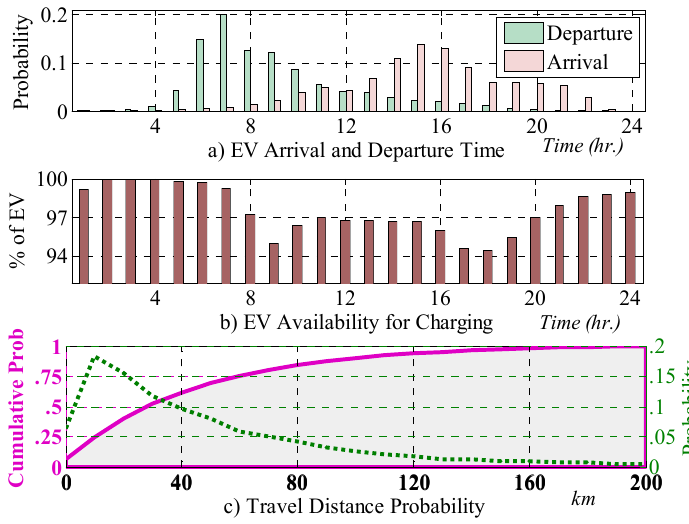
Figure 3. Configuration of EV data for simulation studies.